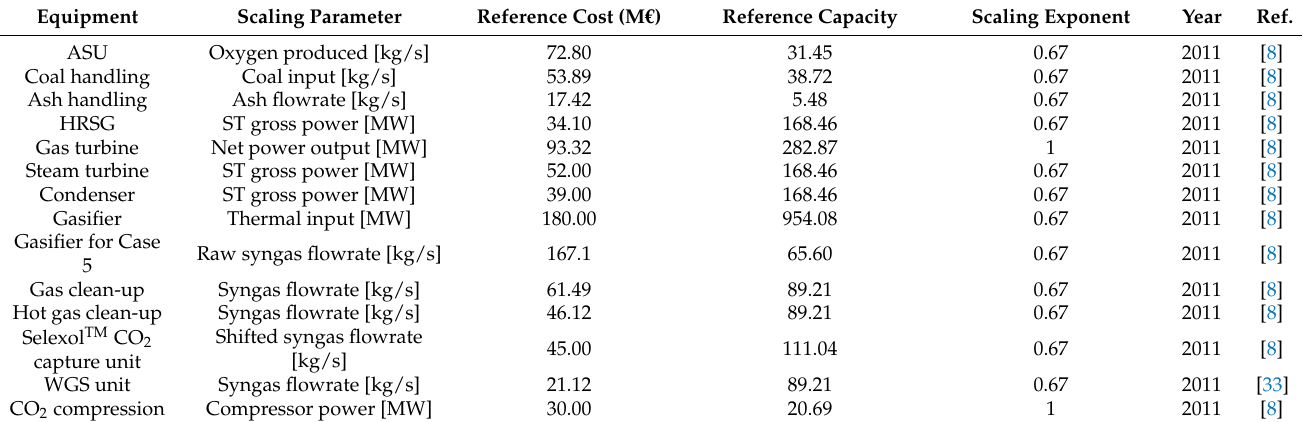
Table 2. Reference costs, capacities and scaling exponents for the cases with CO 2 capture used in Equation (9). Equipment Scaling